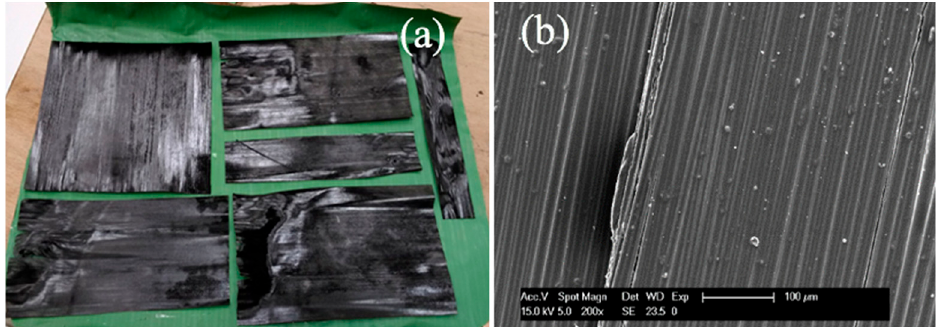
Figure 1. Morphology of the waste: ( a ) scraps layer and ( b ) high-magnification photo of the